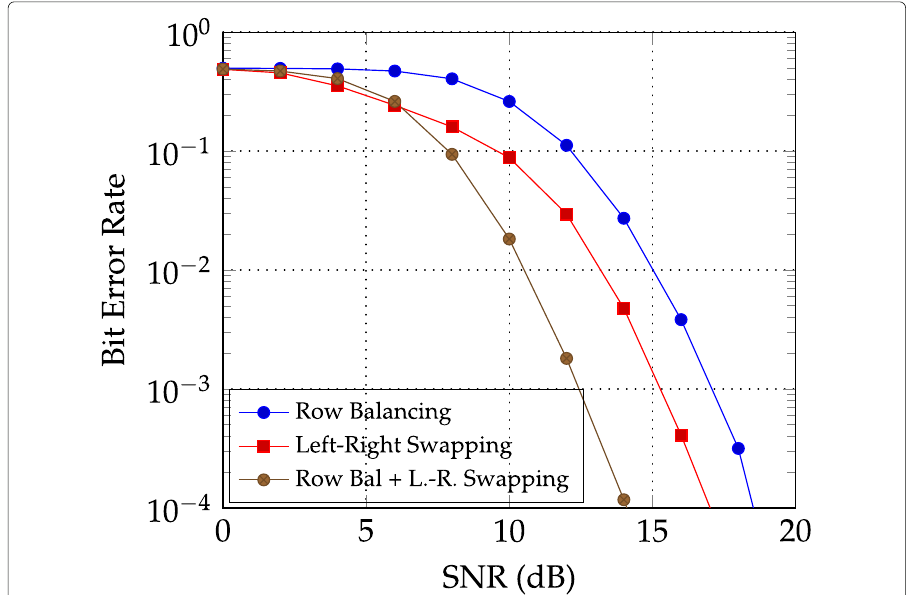
Fig. 8 BER performance in MIMO 3 × 3 by combining “row balancing” and “left-right swapping”